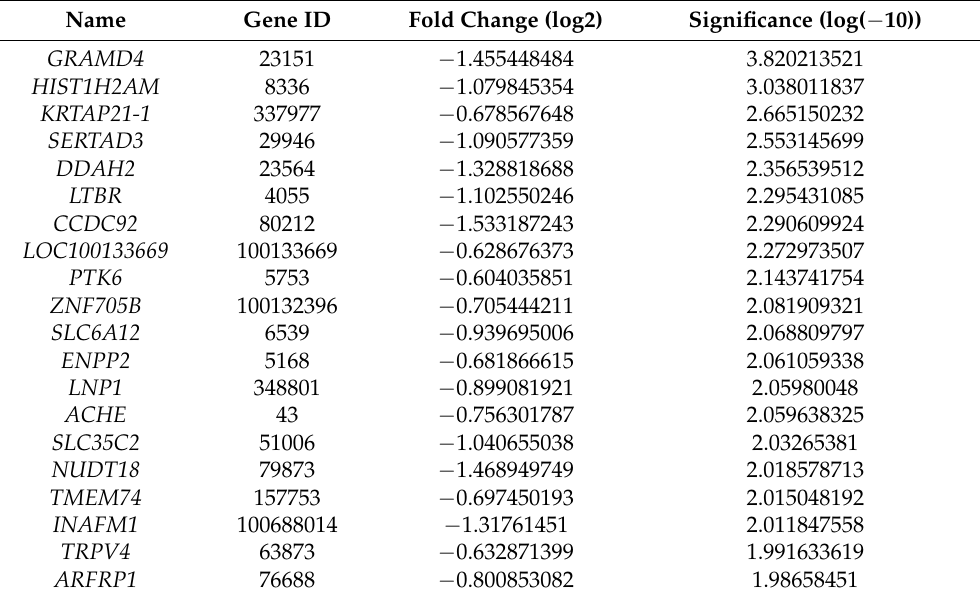
Table 4. Top 20 genes downregulated in OR vs. WT PC cell lines.